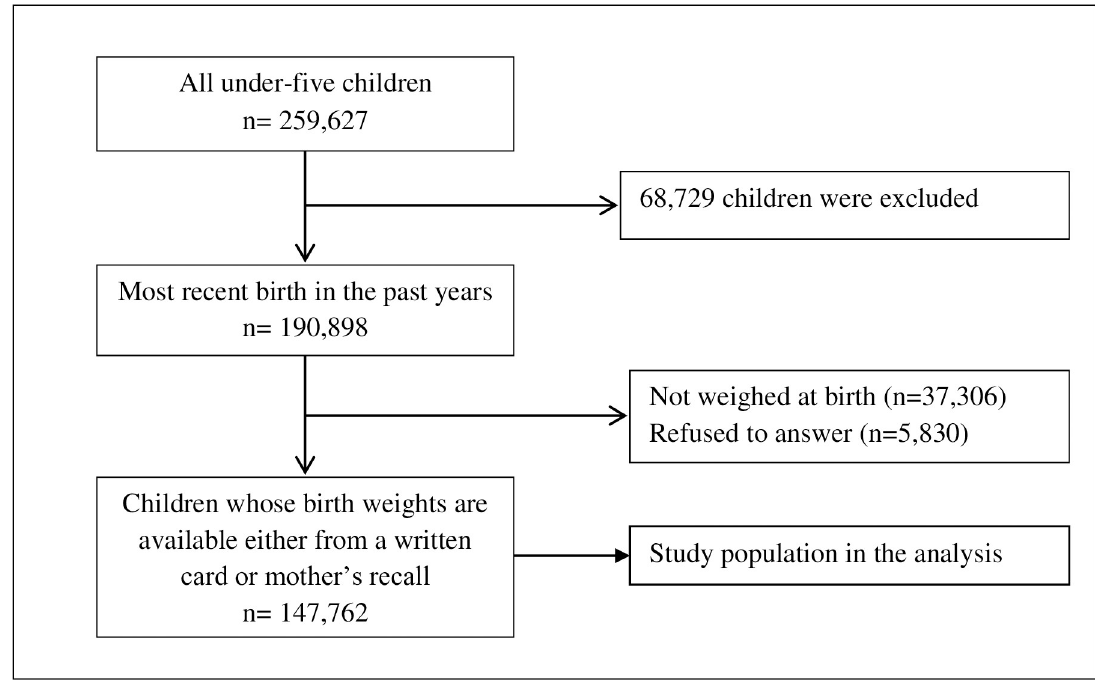
Fig 1. Selection of study participants,